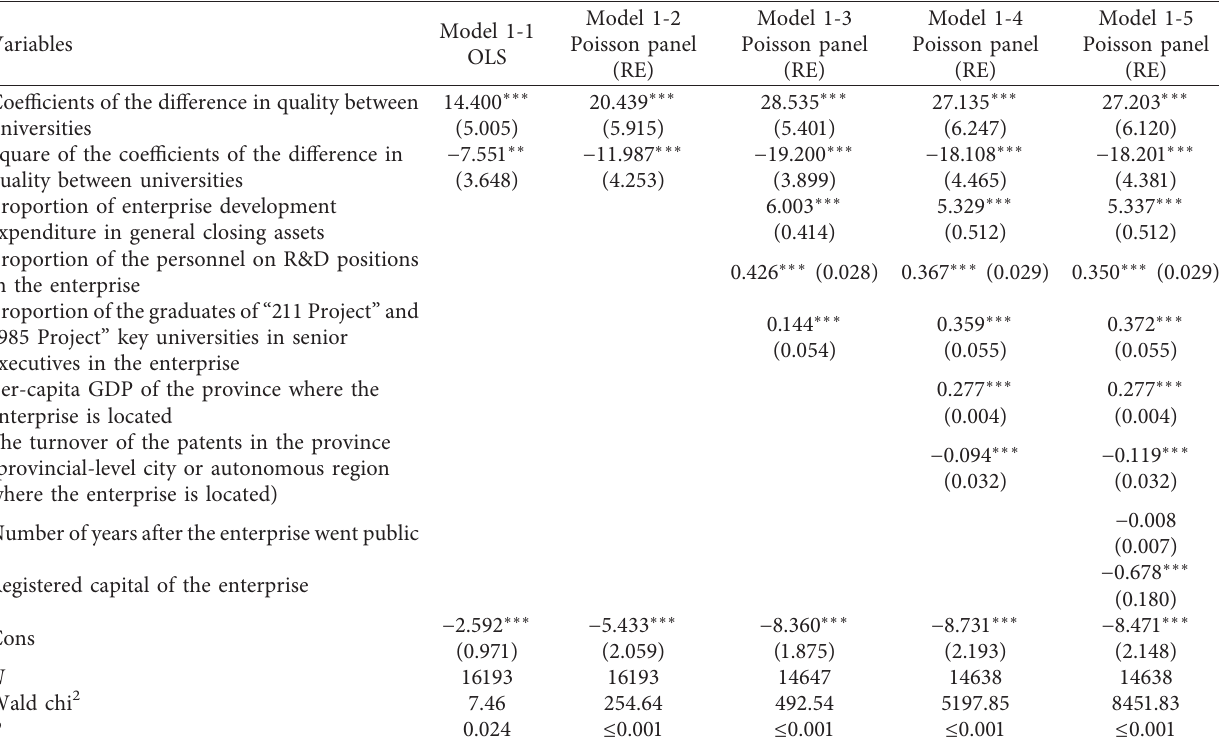
Figure 3: Hypothesis of the relationship between the quality difference between universities and innovation. Note. In thefigure, “ D” denotes the relative amount of differences in quality between universities that are most conducive to national (regional) and enterprise innovation. Table 3: Preliminary analysis and test of enterprise